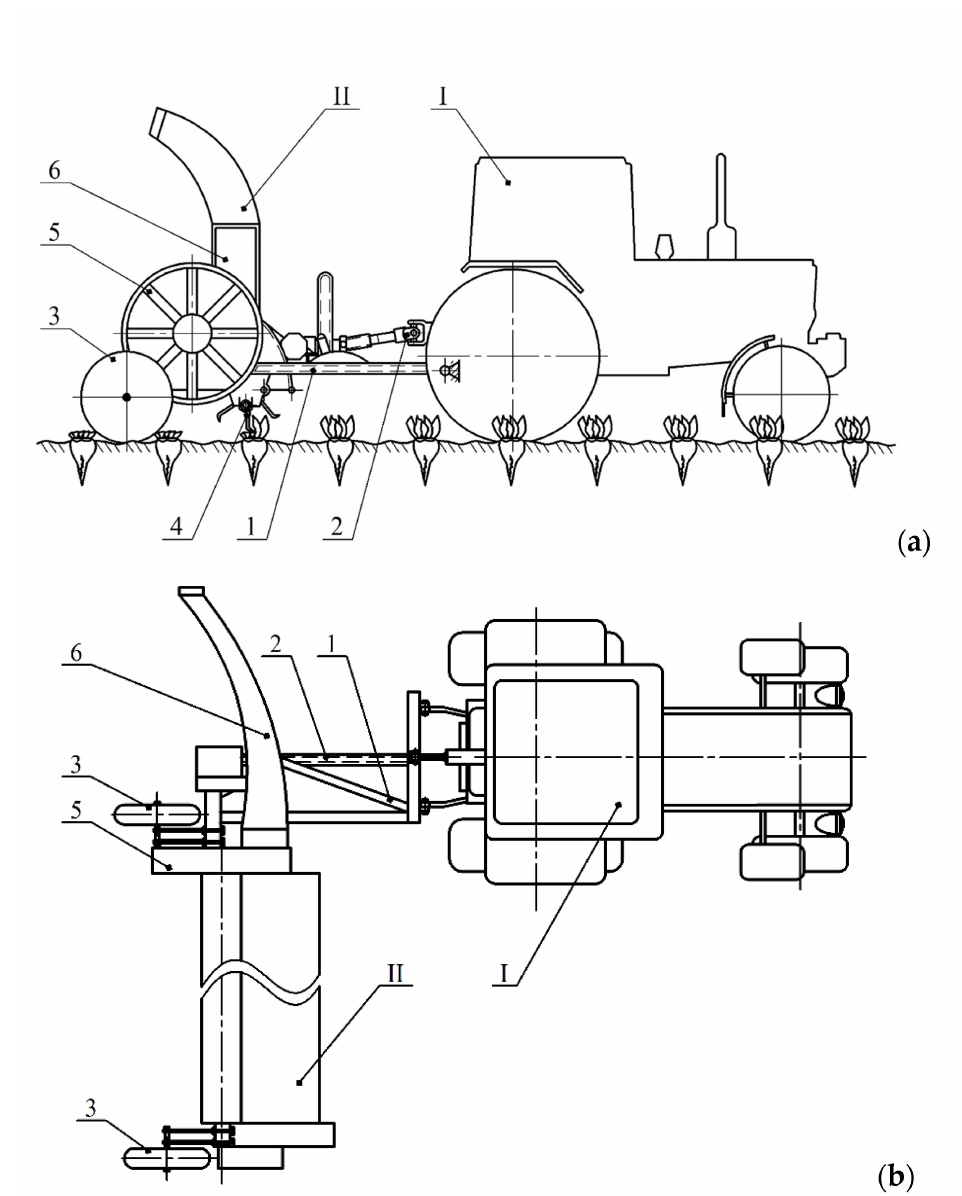
Figure 1. Construction and technological scheme of asymmetric of the haulm harvester ( a )—side view; ( b )—top view: I—wheeled tractor; II—trailed asymmetric haulm harvester: 1—frame; 2—drive; 3—support-copying pneumatic wheel; 4—rotary haulm cropper; 5—transporting working device; 6—loading